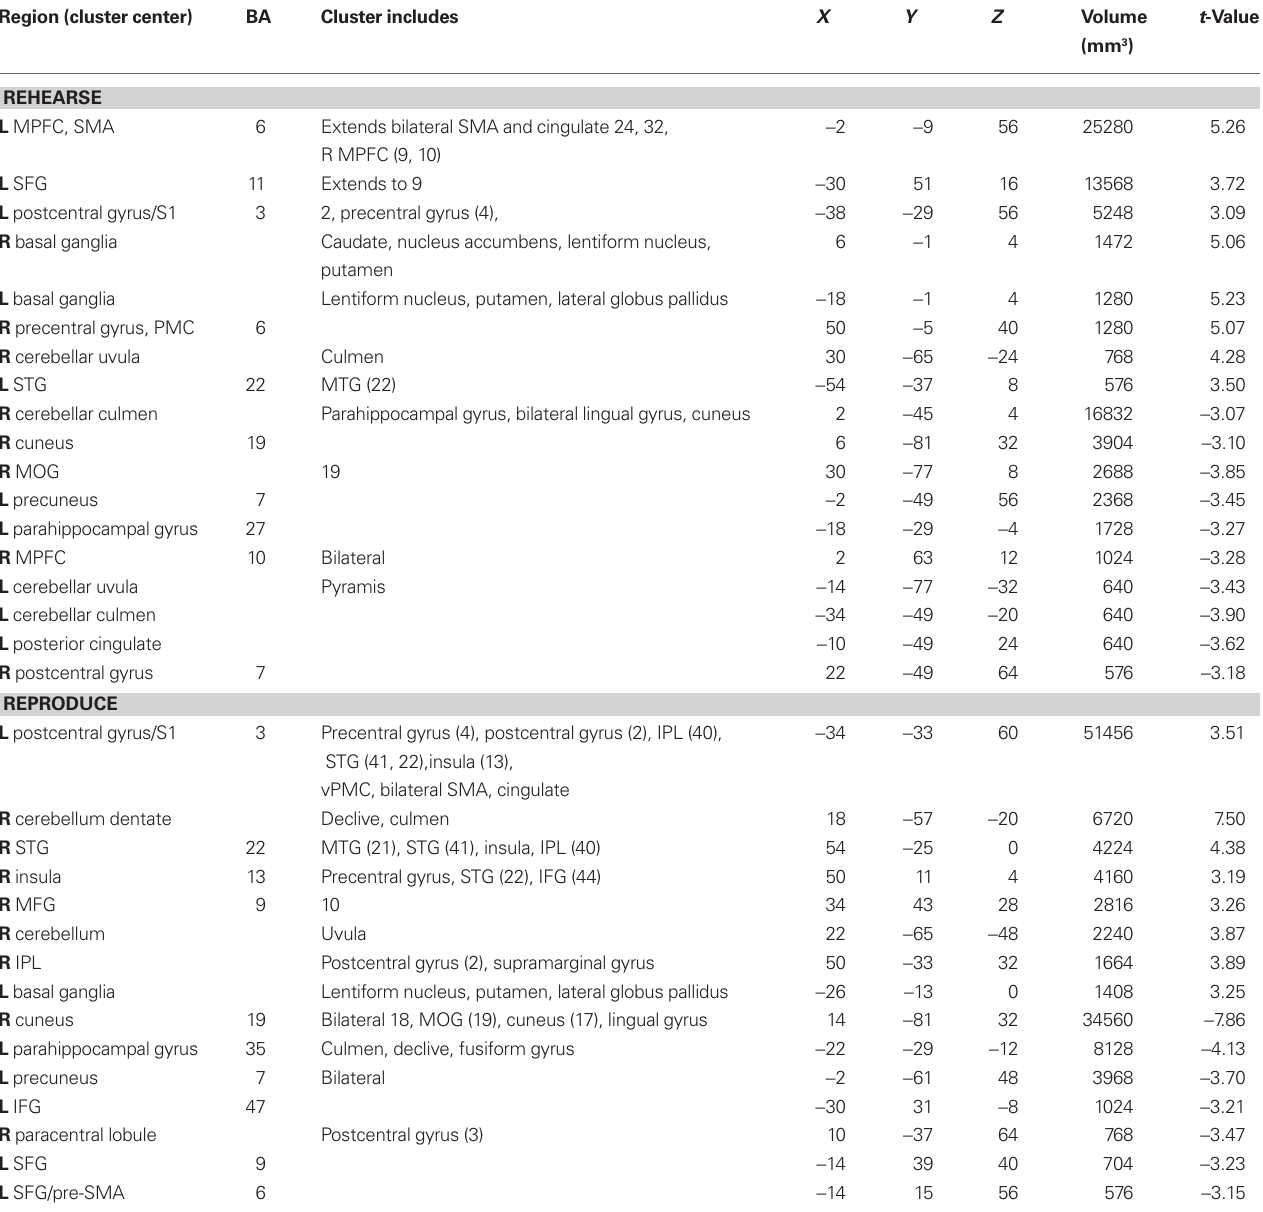
Table 2 | Auditory rehearse and reproduce activations compared to rest ( p < 0.002 corrected). Region (cluster center)